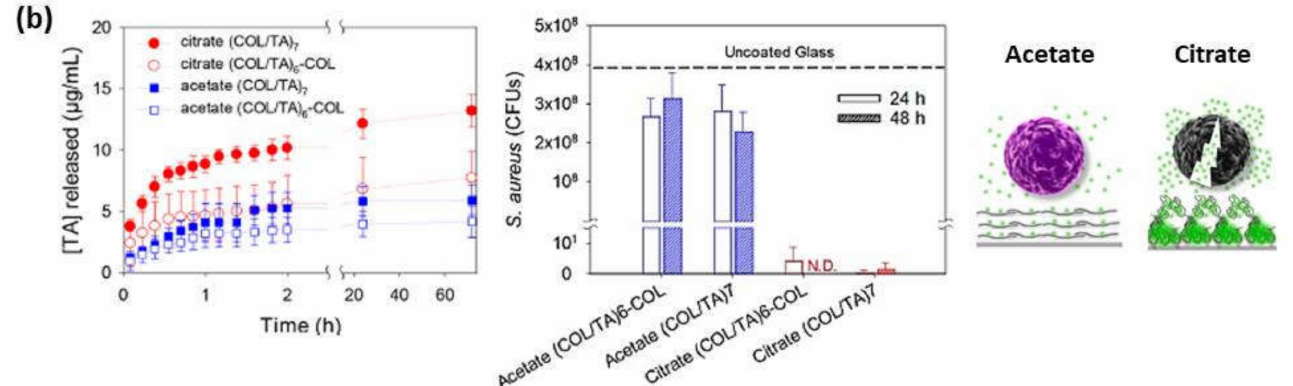
Figure 6. ( a ) Normalized S. aureus growth after 24 h contact with (PAR/HA) 24 multilayer films composed of PAR with a variable number of residues per chain (left) and confocal images (67 × 67 µ m 2 ) of S. aureus after 24 h of incubation on glass substrates, (PAR/HA) 24 films built with PAR10, PAR30, PAR100, or PAR200 and on a glass slide with antibiotics (right). The green channel corresponds to SYTO 24 labeling all bacteria and the red channel only healthy bacteria through metabolism of CTC (5-cyano-2,3-ditolyl tetrazolium chloride) into an insoluble, red fluorescent formazan. (Reprinted with permission from [101]; Copyright 2016 American Chemical Society); ( b ) Cumulative release profiles of TA from TA/COL films in contact with PBS pH 7.4 at room temperature (left), CFU of S. aureus from the supernatant of TA/COL films after 24 and 48 h of contact (N.D. means not detected, no CFUs were observed; dashed line means CFUs were obtained from the bacterial supernatant in contact with an uncoated glass) (center), and schematic representation of TA release-killing toward bacteria (right) (Adapted and reprinted with permission from [103]. Copyright 2020 American Chemical